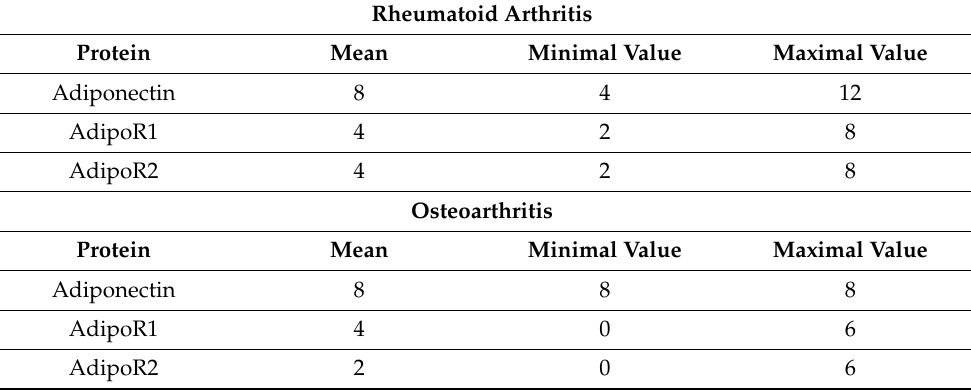
Table 4. Immunoreactive scores (IRS) for fat pad. IRS values: 0—negative, 1–6—weakly positive, 7–12—strongly